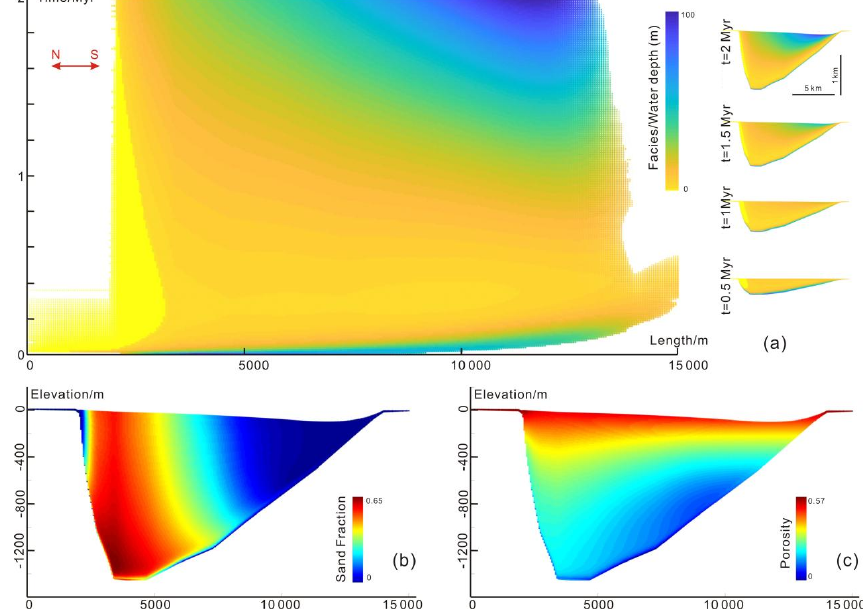
Figure 11. Simulation results of Gaobei Slope Belt during the study interval: (a) Sedapp results of facies in the time domain (Wheeler diagram) and depth domain at different times, (b) Sedapp results of sand fraction in the depth domain, and (c) Sedapp results of porosity in the depth